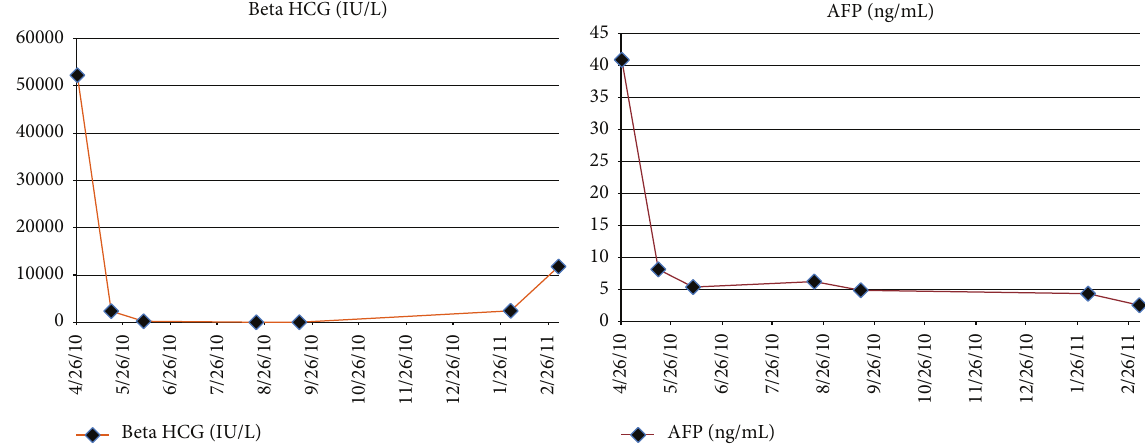
Figure 4: Trends of patient’s beta HCG and AFP levels at diagnosis, during chemotherapy, and at relapse with cardiac, brain, liver, spleen, and skeletal muscle